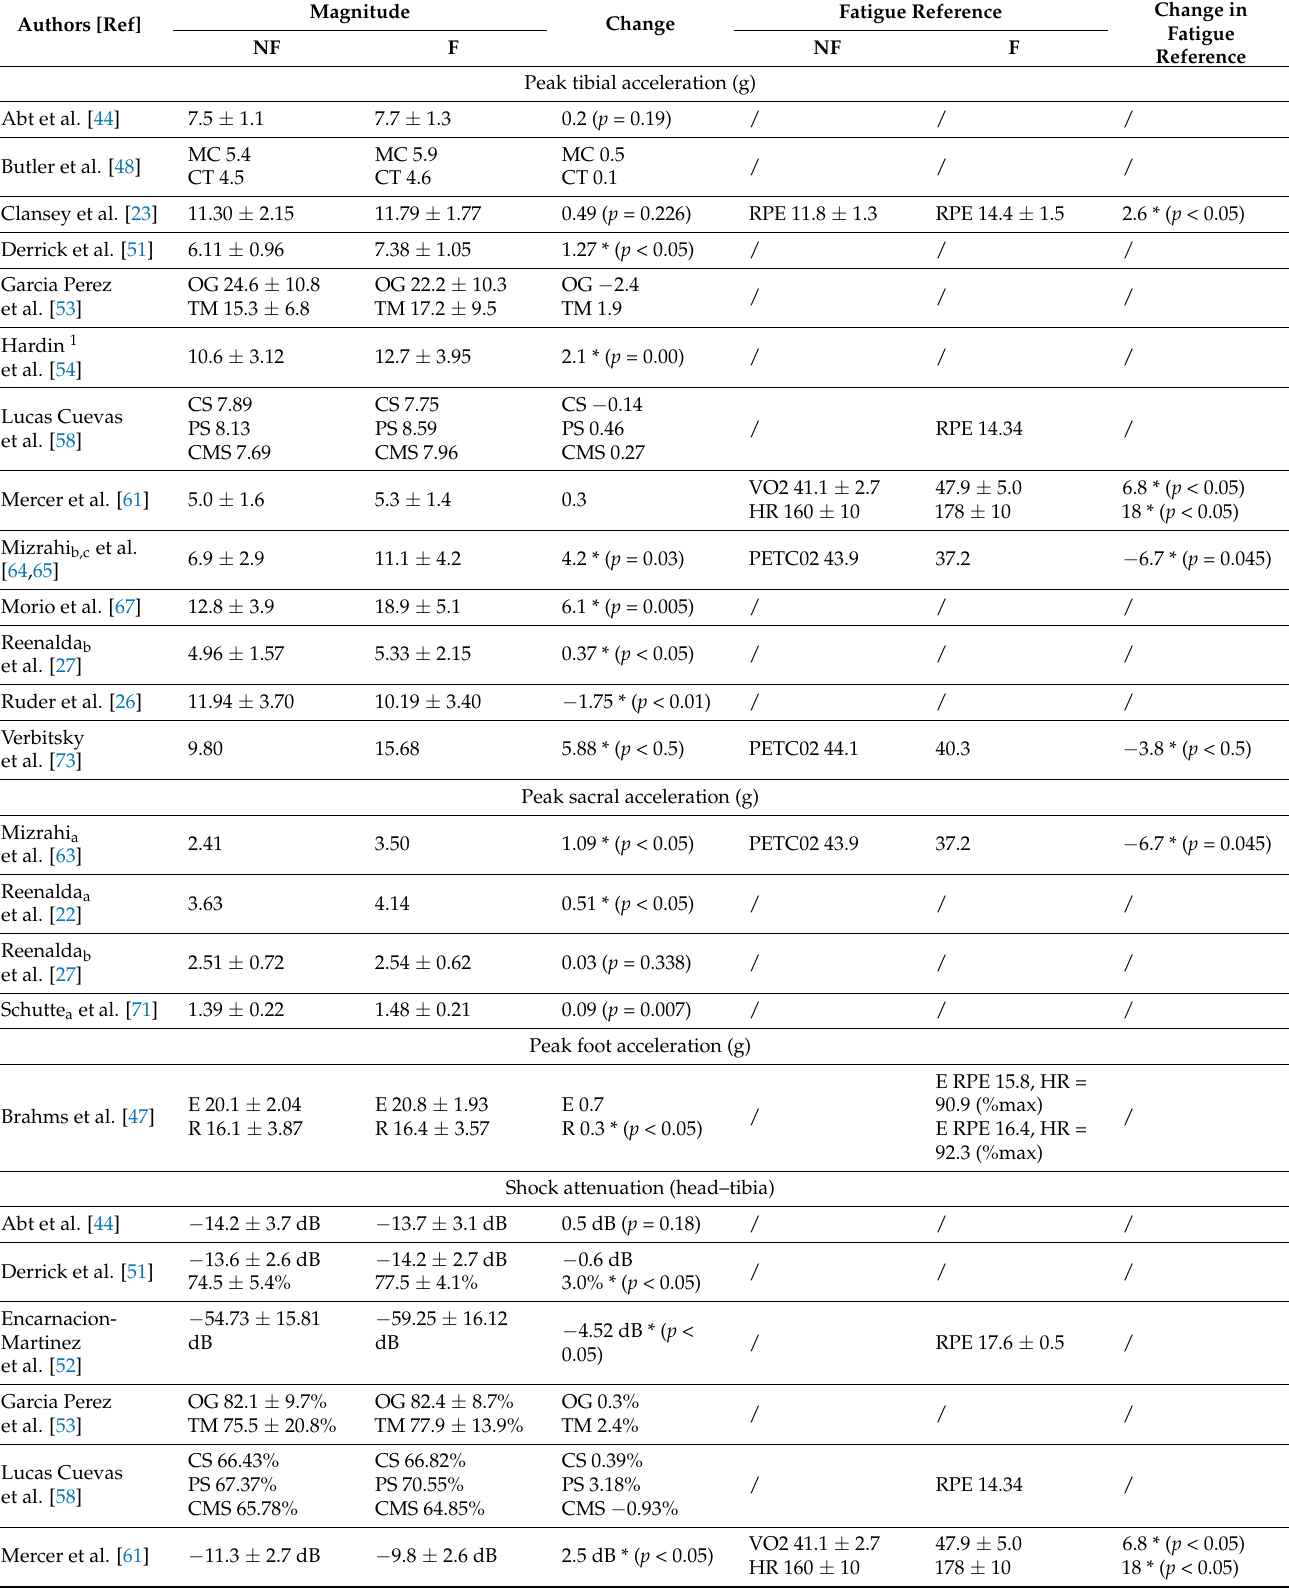
Table 6. Overview of biomechanical changes due to fatigue in